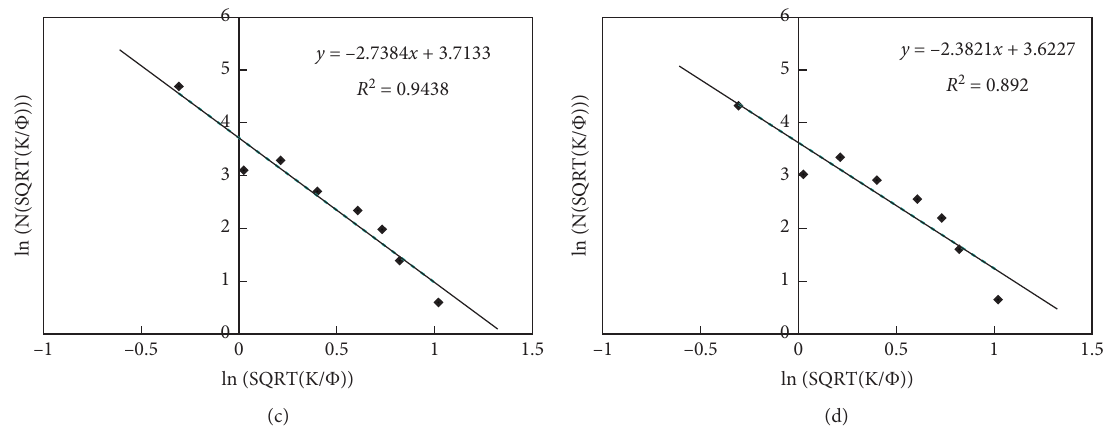
Figure 5: Fractal dimension of composite index of the pore structure. (a) K 71 . (b) K 72 . (c) K 73 . (d) K 74